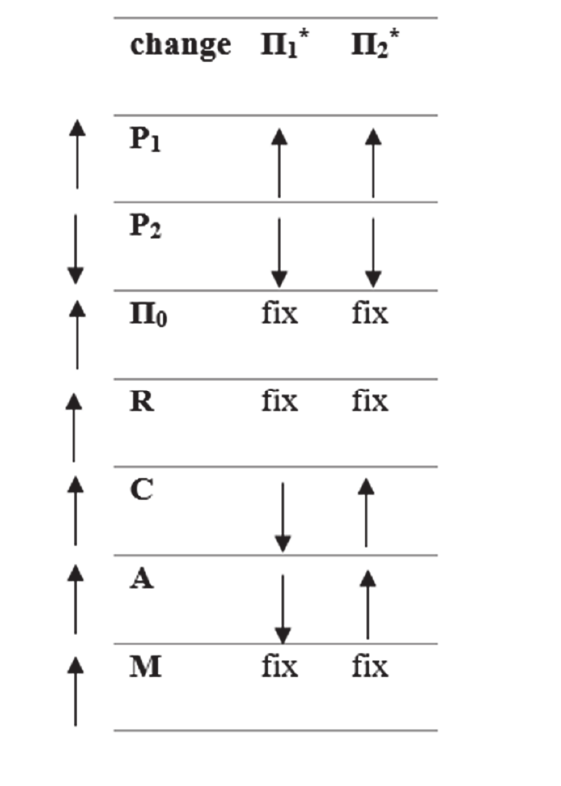
Fig. 6. Sensitivity analysis technique for parameters with regular